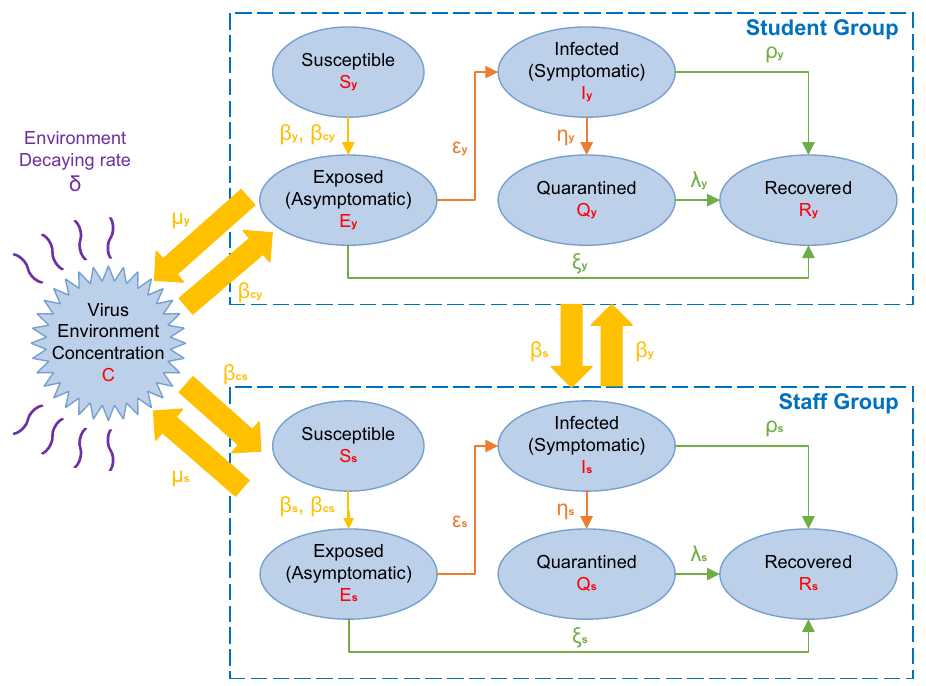
Figure 1. Model structure. Flow chart of five epidemic stages among students and staff in a university department: S, susceptible (including the vaccinated); E, exposed (asymptomatic); I, infected (symptomatic); Q, quarantined (hospitalized or mandatorily isolated); R, recovered. The subscript “y” stands for students while the subscript “s” denotes